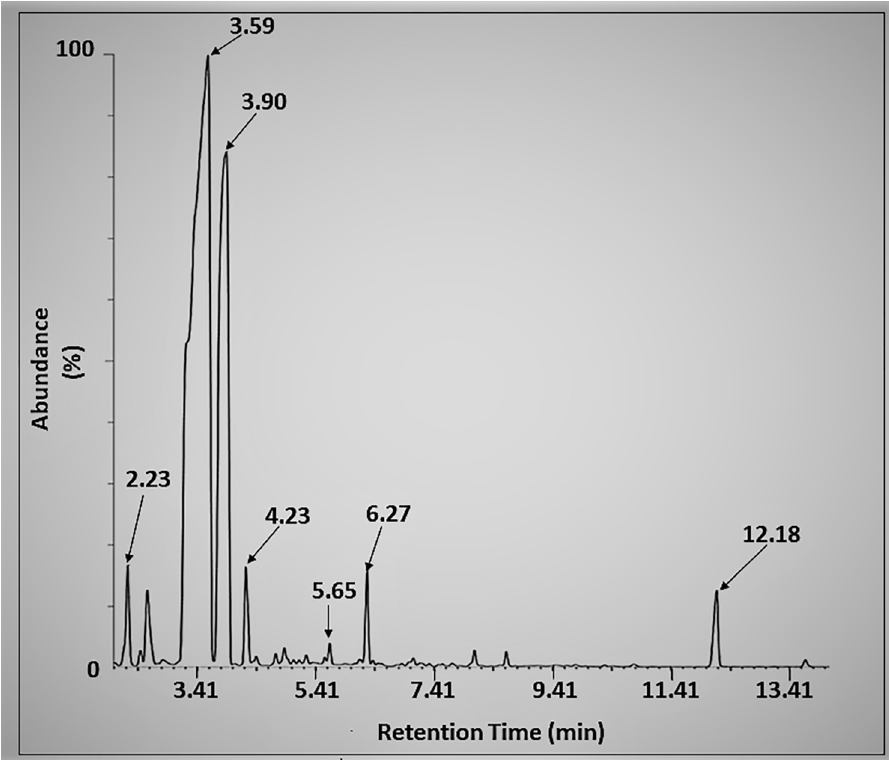
Fig 4. GC-MS chromatogram. Shows NSSO extracted using hexane with 7 major peaks at specific retention times (RT) that correspond to different components i.e., toluene (2.23 min), 4-Pyridineethanesulfonic acid (3.59 min), propanenitrile, 3-chloro (3.90 min), N-(2-Hydroxyethyl)-N-methylaniline (4. 23 min), decane (5.65 min), m-cymene (6.27 min) and allopurinol (12.18 min), respectively.